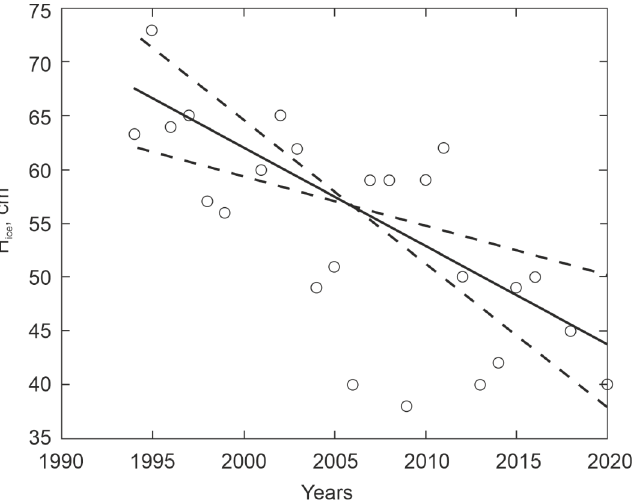
Figure 3. Maximal snow-ice cover thickness on Lake Vendyurskoe in spring in 1994–2000, 2002–2018, and 2020 (field data). Solid line—linear trend, dashed lines—95% confidence interval.